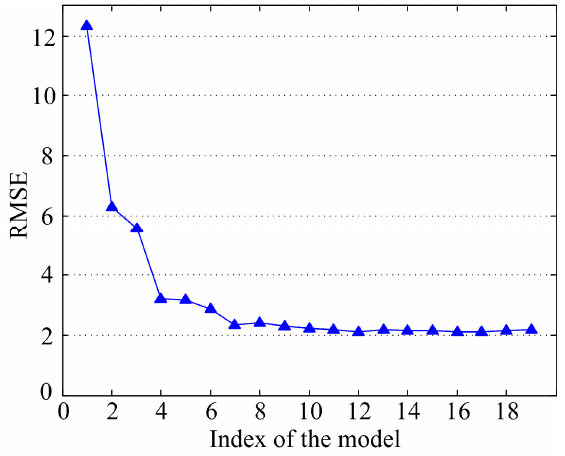
Figure 7. The change of RMSE versus the increase of input parameters of the